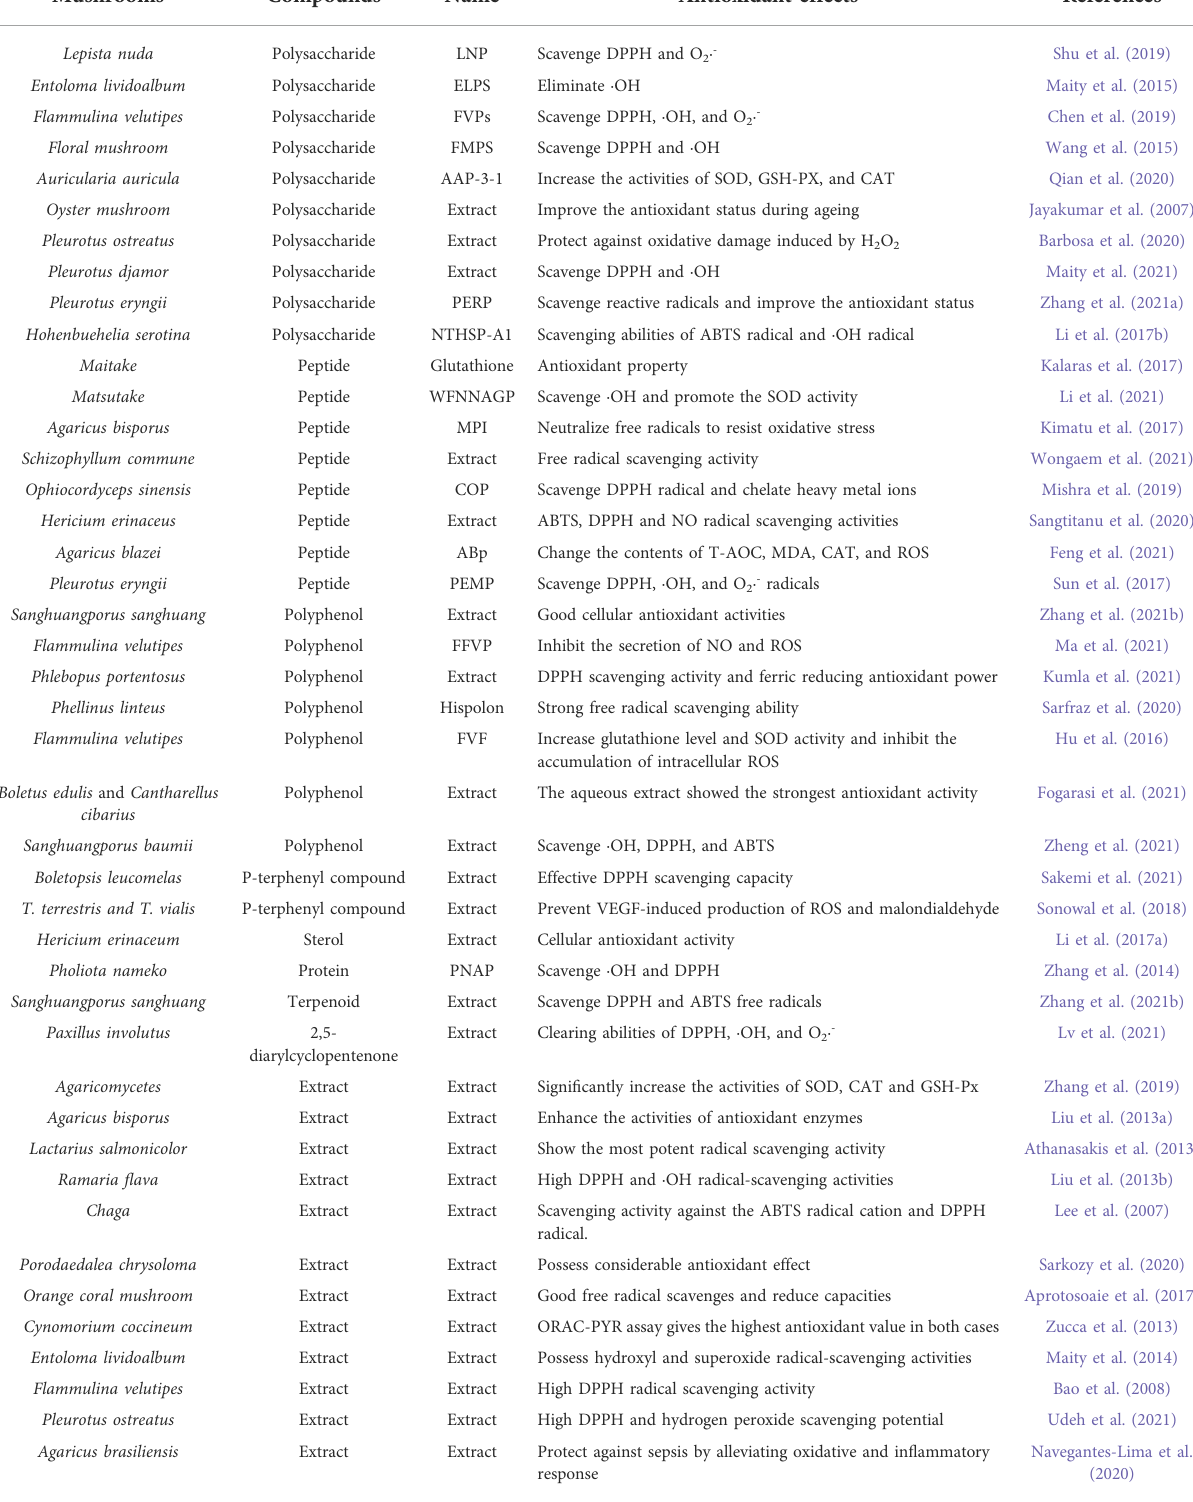
TABLE 1 Antioxidant effects of compounds puri fi ed from